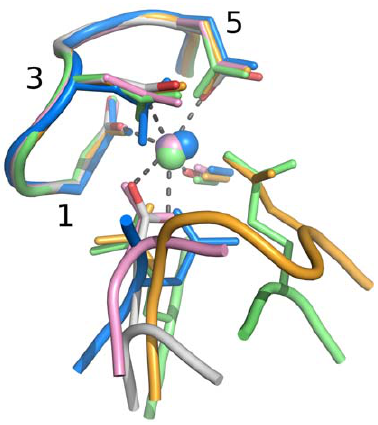
Figure 1. Comparison of Dx[DN]xDG calcium-binding motifs in calmodulin and the new structural contexts presented here. The metal (sphere) is bound by the side chains of the Dx[DN]xDG motif (labelled 1, 3, 5) and the carbonyl group of the residue immediately following the motif. These, and the entire motif backbone, superimpose very well, while additional contributions to binding from later residues vary hugely in spacing and number (see text, Table 1 and Fig. 2). The representative calmodulin (PDB code 1exr) is coloured by atom type, with carbon white, oxygen red and bound calcium in purple. Other structures and their bound calcium ions are coloured uniformly with T. kodakaraensis subtilisin (PDB code 2z2x) in orange, endo- a -N-acetylga- lactosaminidase (PDB code 2zxq) in pink, E. coli YgjK (PDB code 3c68) in green and the Porphyromonas adhesion domain (PDB code 3km5) in blue. Interactions of calmodulin with bound metal are shown as dotted lines.